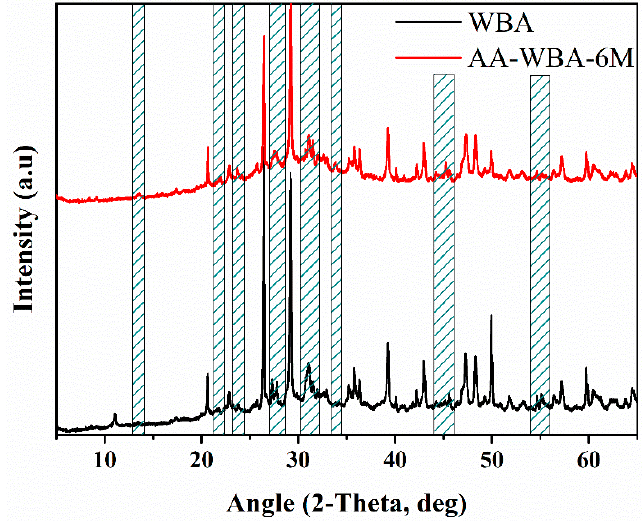
Figure 4. XRD patterns of WBA and AA-WBA-6M.